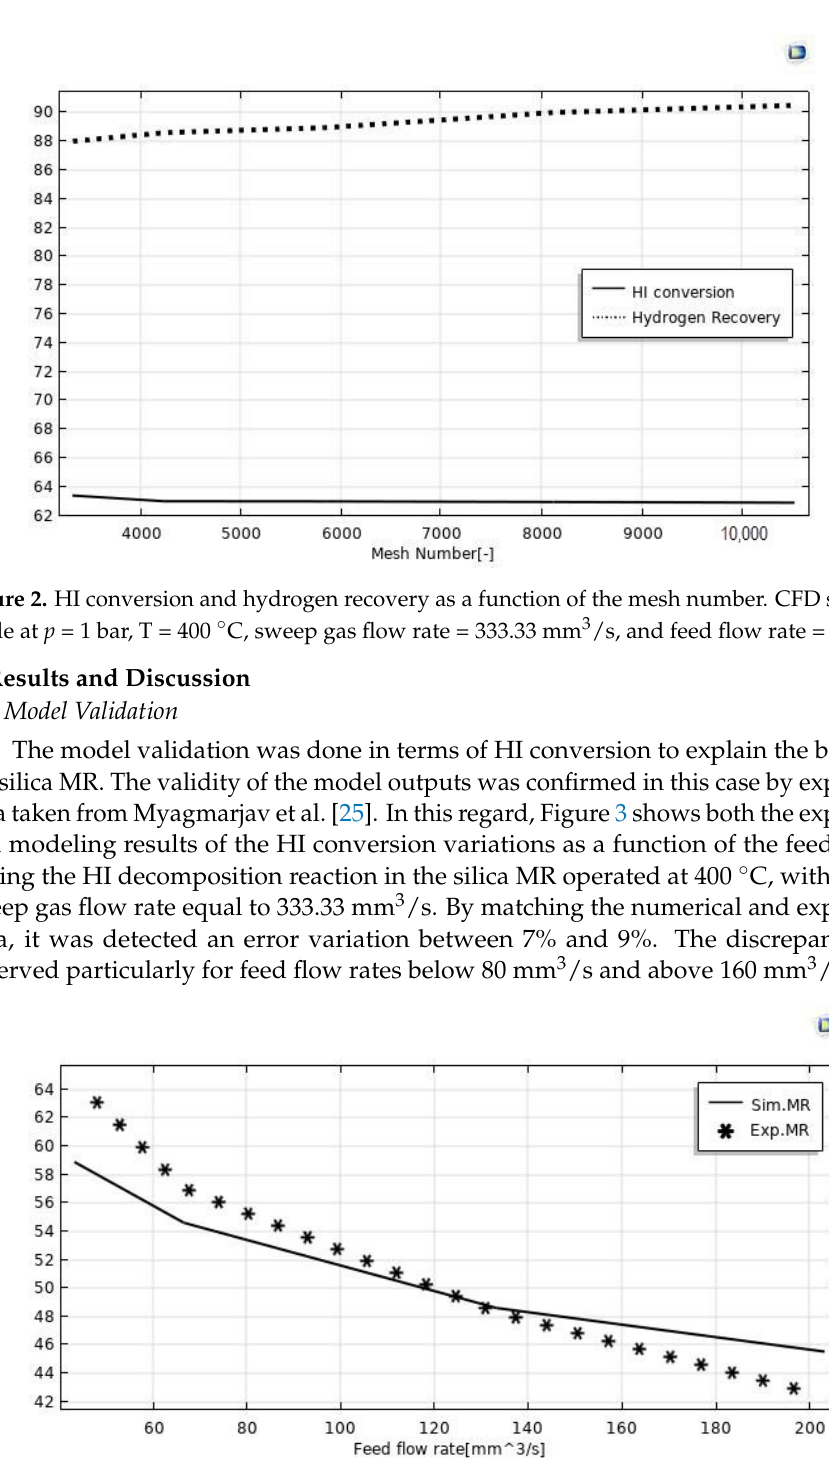
Figure 3. HI conversion in the MR vs. feed flow rate at T = 400 °C, p = 1 bar, and sweep gas flow rate = 333.33 mm 3 /s.